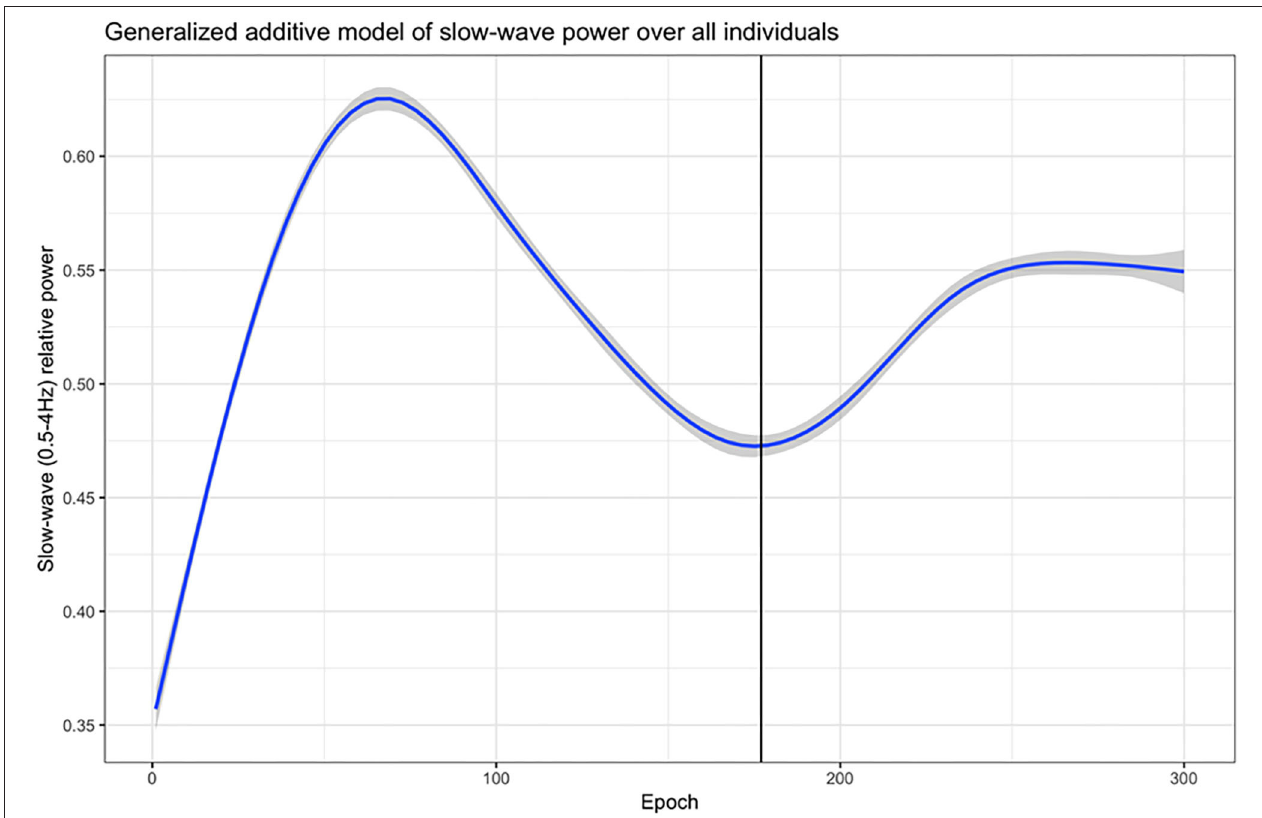
FIGURE 1 | The first ultradian cycle of slow-wave activity (0.5–4Hz band). A generalized additive model was used to generate a smoothed estimate of the relative slow-wave power (0.5–4Hz band) progression for each individual over the first 300 epochs (150min). The solid vertical line in the graph: The first post-elevation nadir of relative slow-wave power at 177 epochs ( = 88.5min) in this cohort-wide